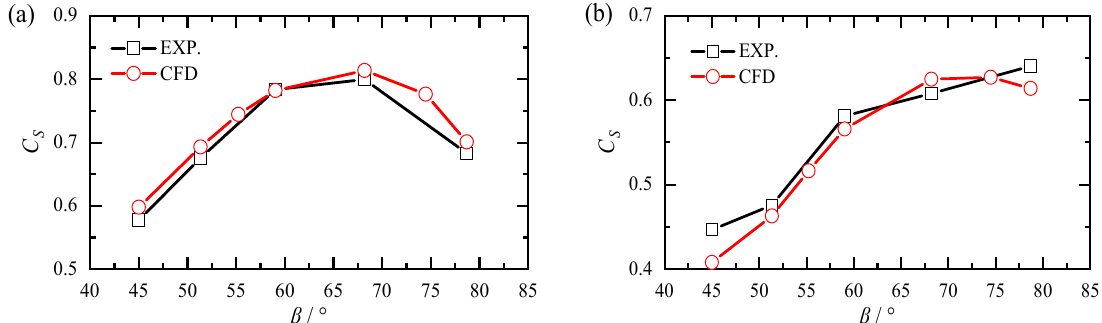
Figure 6. Comparison of aerodynamic coefficients in the simulation and test: ( a ) side aerodynamic coefficient of the head car; ( b ) side aerodynamic coefficient of the middle car.